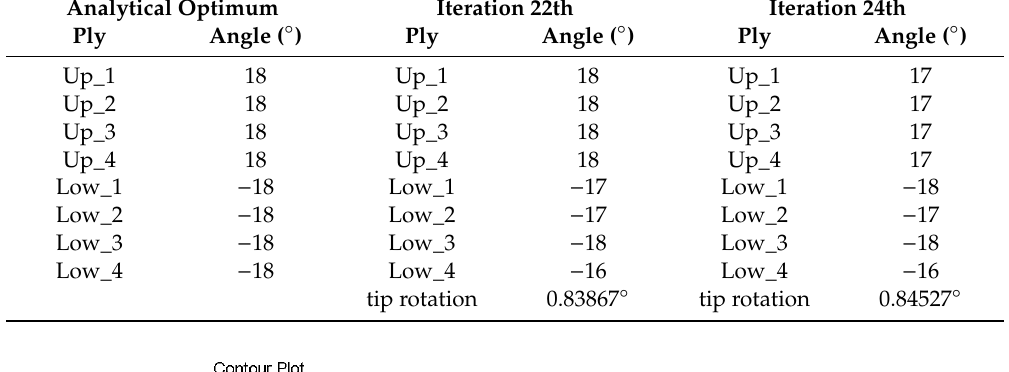
Table 2. Ply angles of best results by theoretical approach, gauge optimization (iterations 22th and 24th).